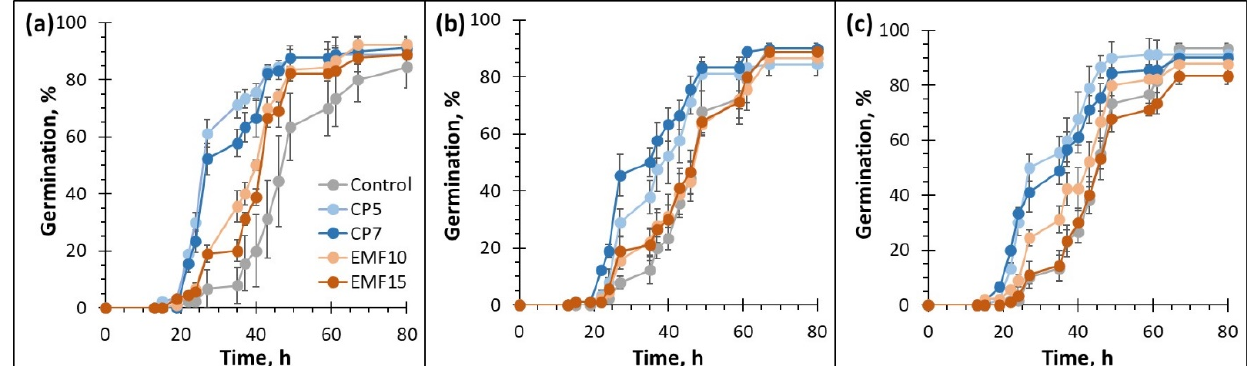
Figure 2. Germination dynamics of control and treated seeds of red clover—yellow ( a ), brown ( b ), and dark purple ( c ) seeds. Mean values of three replicates ± standard error are presented. The number of seeds in each replicate was 50 ( n = 3). Table 1. Indices of germination kinetics of control and treated red clover seeds of different color. Seed Color Germination